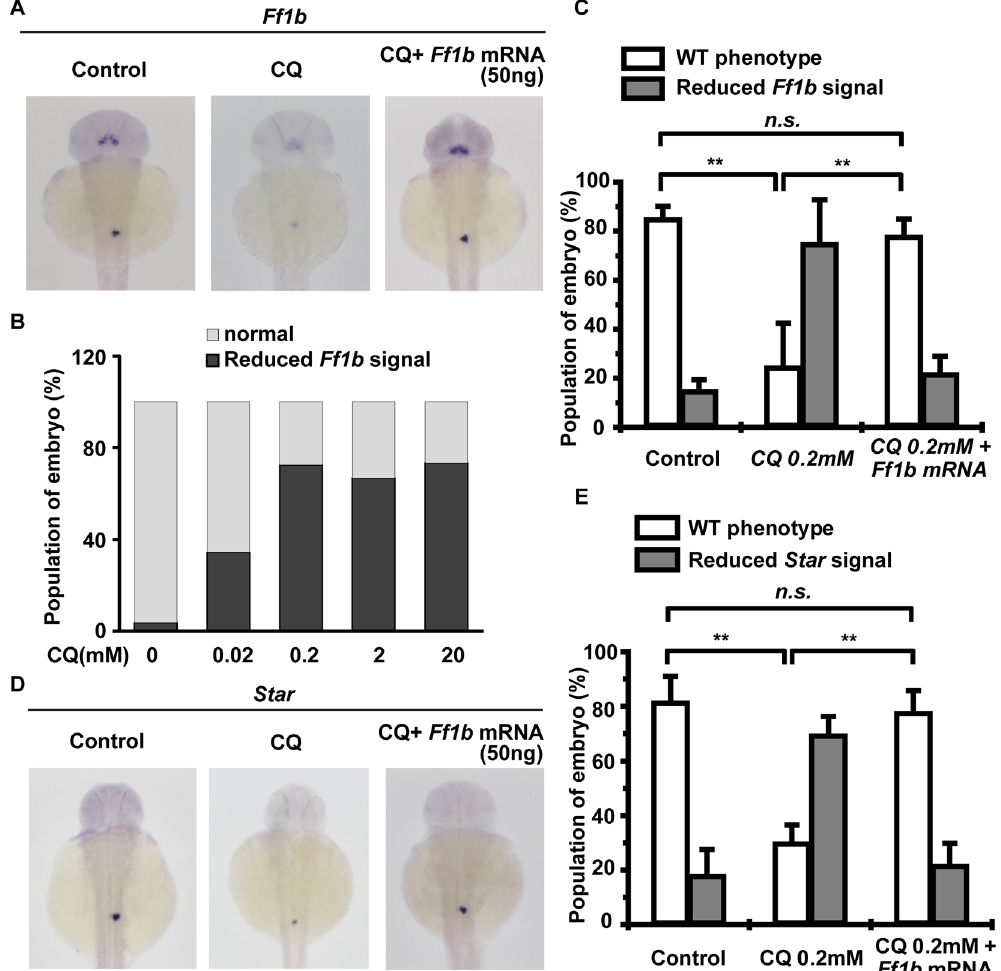
Figure 8. Chloroquine inhibits interrenal gland development. ( A – C ) Chloroquine reduces interrenal gland development in zebrafish embryo. ( A ) The whole mount in situ hybridization of Ff1b in the wild-type like (WT), or CQ-treated (reduced) with or without Ff1b mRNA injected zebrafish embryo. (B-C) Quantitation result of zebrafish embryo with reduced Ff1b signal in the presence of different dose of CQ ( B ) or injected with Ff1b mRNA ( C ). ( D , E ) Reduced steroidogenic enzyme expression in CQ-treated zebrafish embryo. ( D ) The whole mount in situ hybridization of Star in the wild-type like (WT) or CQ-treated (reduced) with or without Ff1b mRNA injected zebrafish embryo. ( E ) Quantitation result of ( D ). n.s.: no significance; ** P <